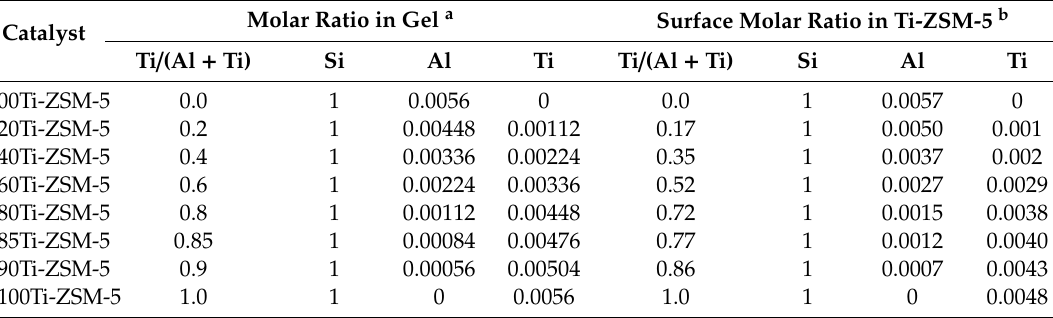
Table 1. Element molar ratio in gel and surface of hierarchical porous Ti-ZSM-5.